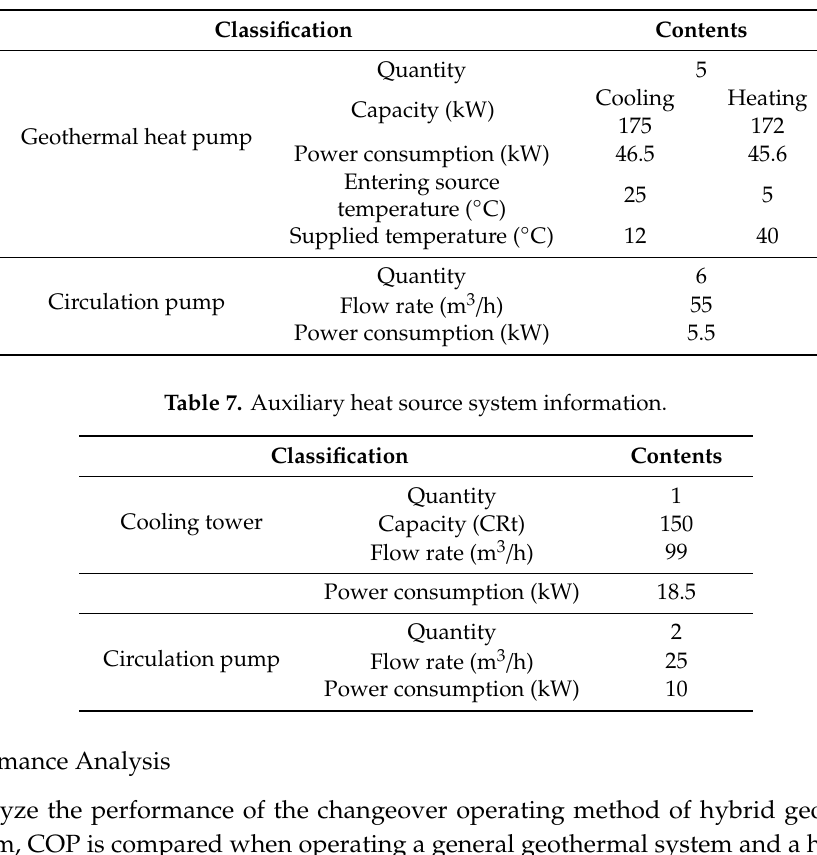
Table 6. Geothermal heat pump system information.